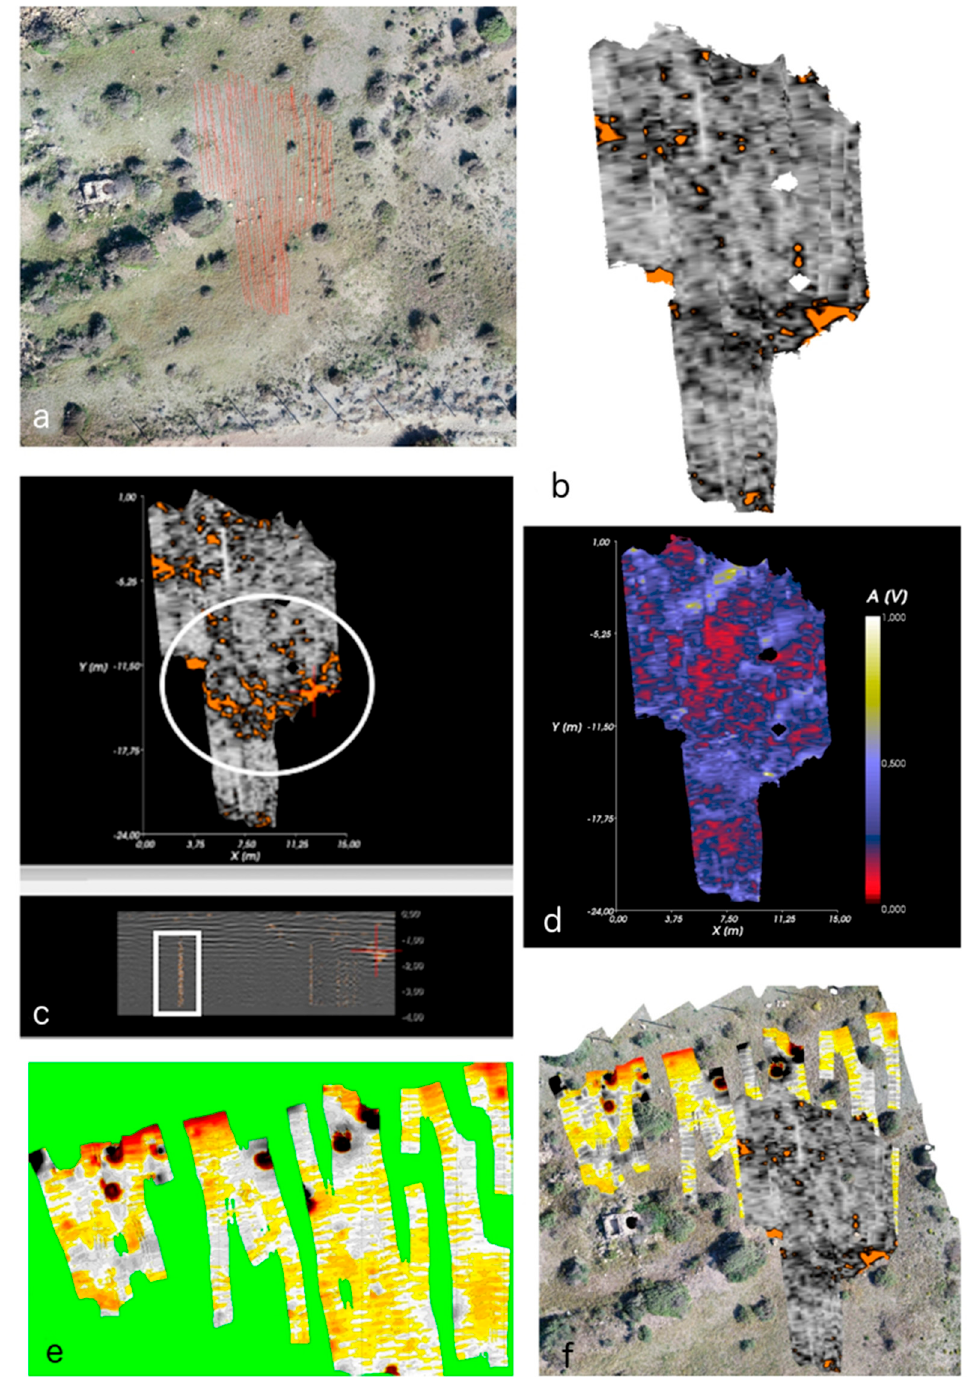
Figure 17. Detailed results of GPR and Magnetometry scans. Potential dumping area marked with a white circle and square.